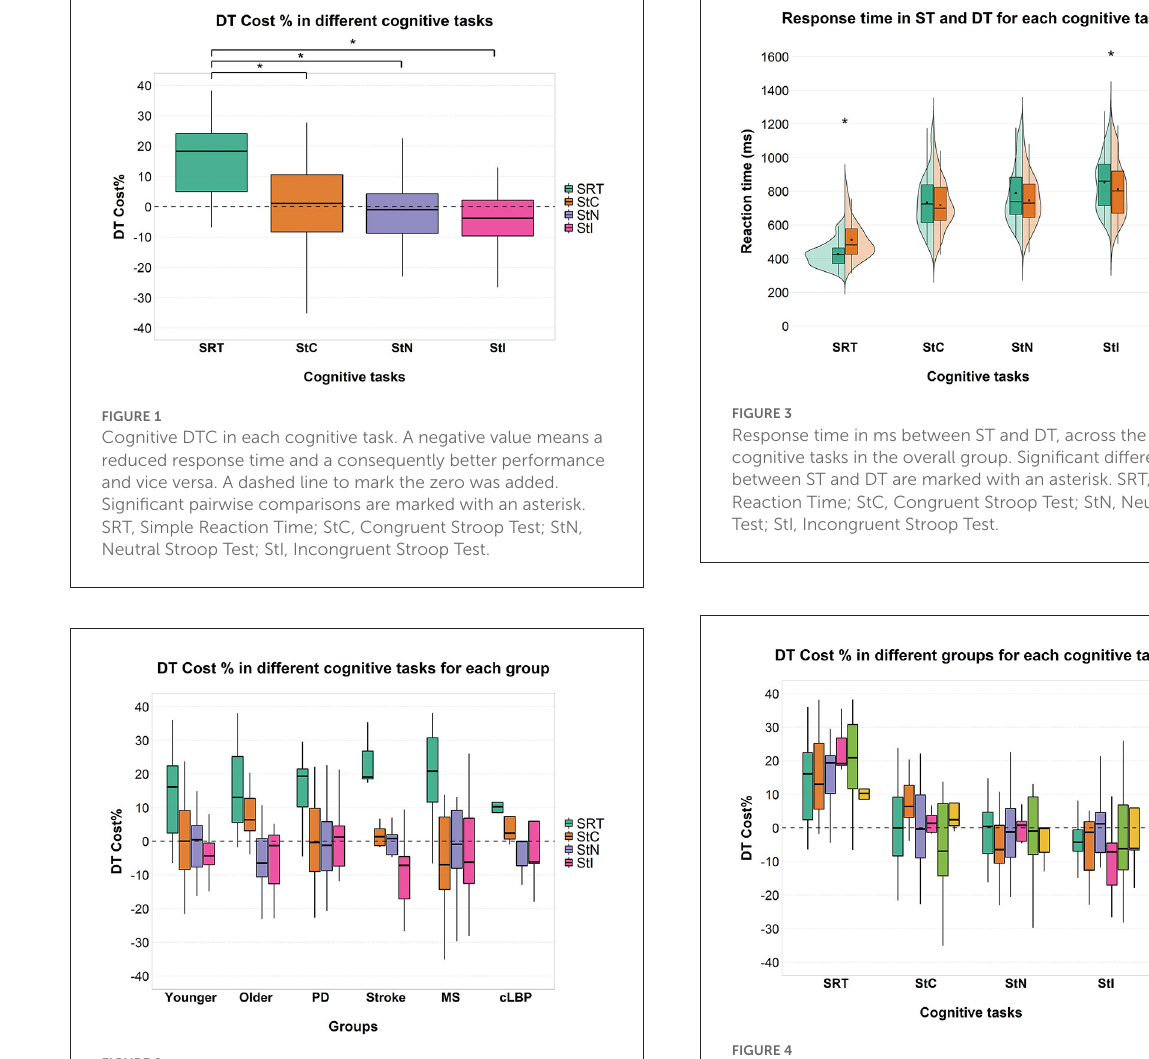
FIGURE2 Cognitive DTC across the different cognitive tasks in each group. A negative value means a reduced response time and a consequently better performance and vice versa. A dashed line to mark the zero was added. SRT, Simple Reaction Time; StC, Congruent Stroop Test; StN, Neutral Stroop Test; StI, Incongruent Stroop Test.